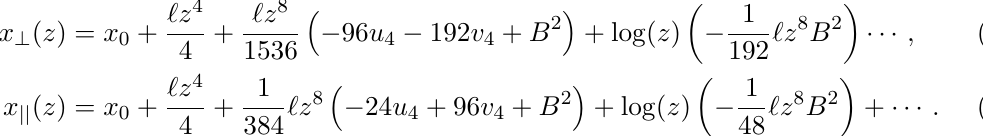
Figure 9 . The difference in entanglement entropy as calculated with Chern-Simons coupling γ = √ 2 / 3 and γ = 0 is displayed as a function of B/T 2 . Left: Parallel to magnetic field. Right: perpendicular to the magnetic field. The colors correspond to strips of width ‘ = 2 / 10 to strips of width ‘ = 5 as displayed by the inset plot legend. The curves were computed at a fixed µ/T = 5 . Expanding both the parallel and transverse case along with the vacuum surface near the AdS boundary, we